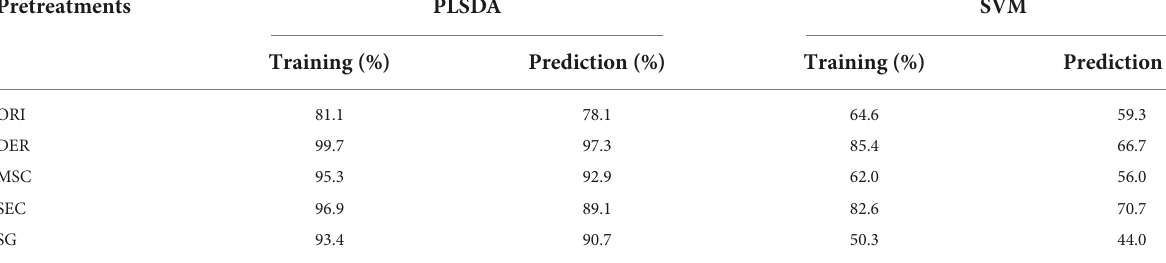
TABLE 3 Multi-origin discrimination of fruits using PLSDA and SVM models.